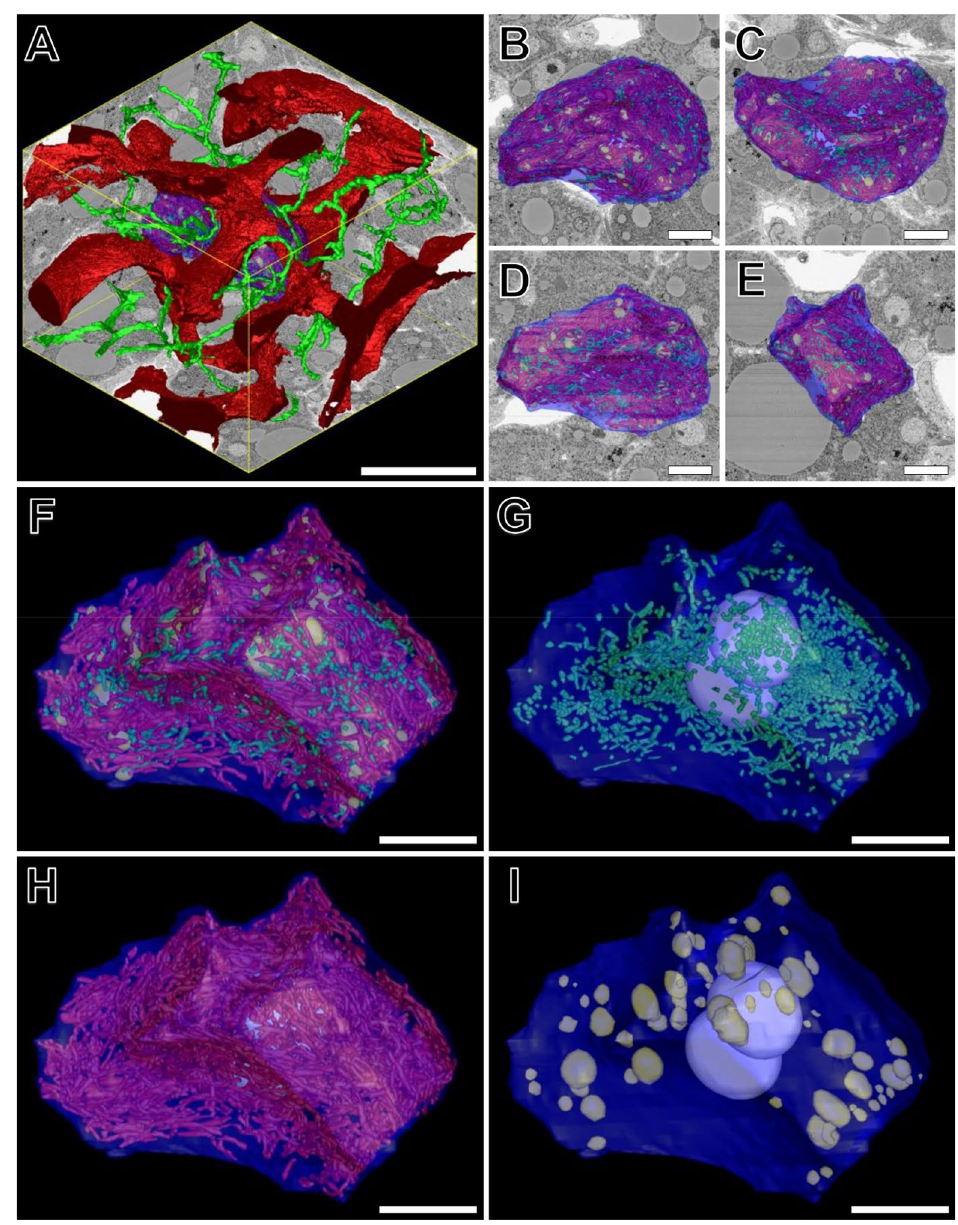
Figure 3. ( A ) Reconstructed 3-D volume consisting of 400 consecutive images (section thickness = 150 nm). XY = 84.82 µm, Z = 60 µm. Total volume = 453,249 µm 3 . Magnification 1200×. The volume contains a 3-D reconstruction of a hepatic parenchymal cell (HPC) (blue) from patient 4, surrounded by the hepatic sinusoidal network (red) and bile canaliculi (green). ( B and C ) show top and bottom views, respectively, of the HPC of interest, overlayed with an XY inverted backscattered SEM (BSEM) image. ( D and E ) reveal front and right-side model views, respectively, overlayed with corresponding XZ and YZ BSEM images. ( F – I ) reveals higher-magnification model views of the HPC and corresponding model views of normal- (green) and giant mitochondria (red), lipid droplets (yellow) and nuclei (white). Scale bars: ( A ) = 30 µm; ( B – I ) = 10